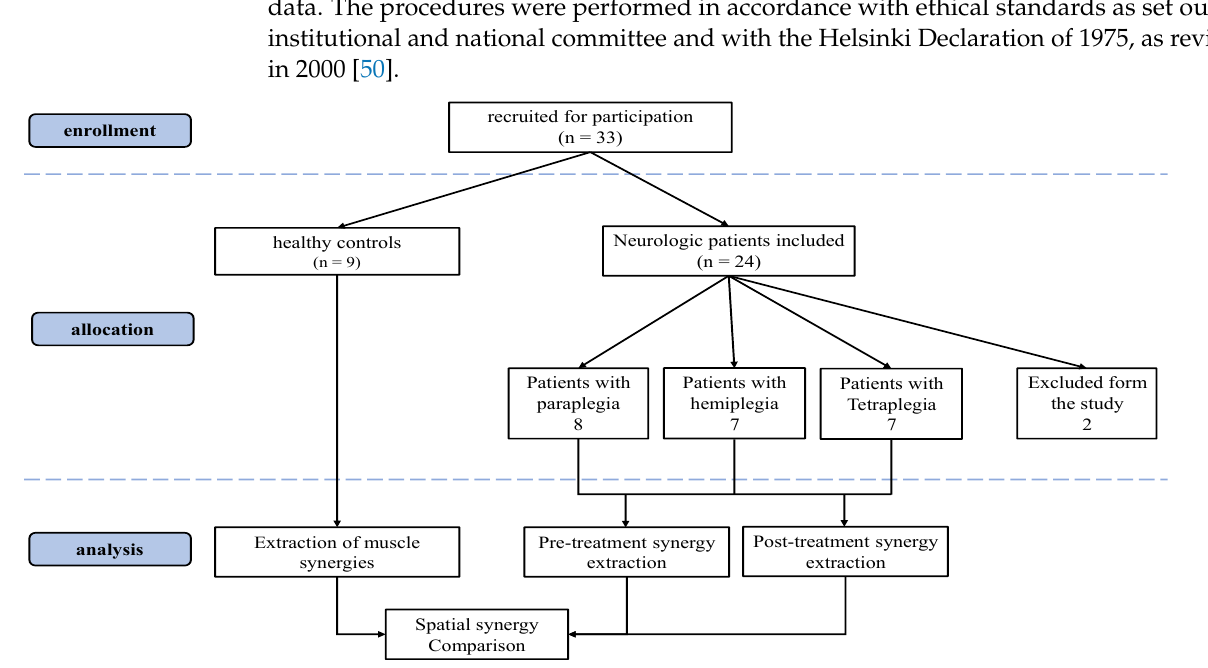
Figure 1. Consolidated Standards of Reporting Trials (CONSORT) flow diagram.